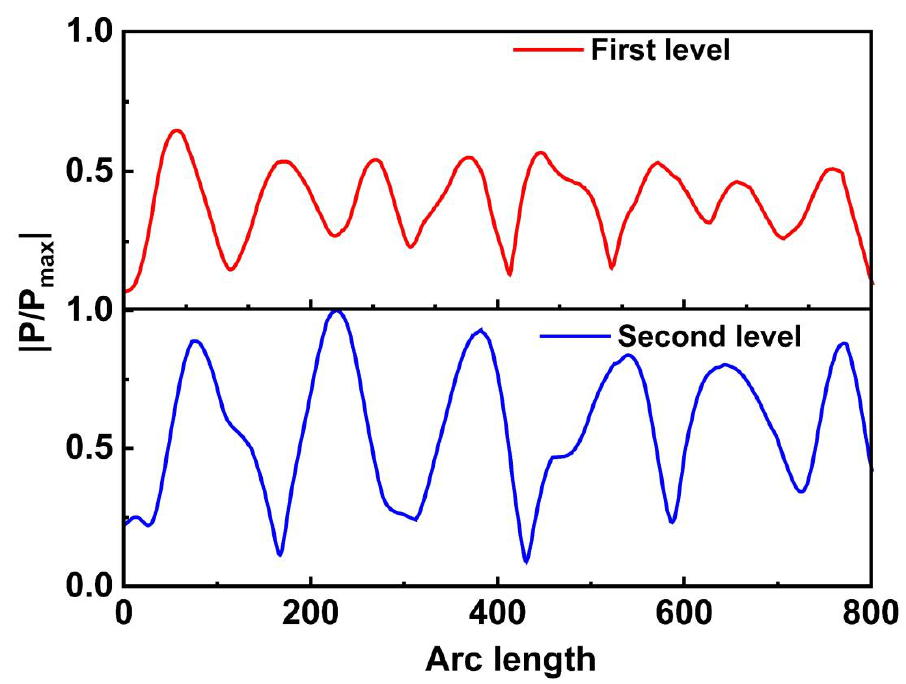
Figure 10. The normalized acoustic pressure generated by the multi-stage SAW device. Based on the results of single-stage separation, the separation of three different particle sizes achieved by multi-stage IDT with an acoustic pressure at 0.45 MPa in the first stage (top) and an acoustic pressure at 0.75 MPa in the second stage (bottom) is shown in Figure 11b, where the red lines represent the largest particles (25 μm), the green for me- dium- sized particles (15 μm), and the blue for the smallest (5 μm) particles. In the first stage, the ARF dominates the larger particles, which causes the particles to flow in the direction of the inclined node. In contrast, the drag force cancels most of the acoustic ra- diation force of the remaining particles, resulting in a small lateral displacement. When these particles enter the second sorting area, the acoustic radiation force continues to sep- arate the largest particles farther away, and when the mixed particles move through the SAW, the medium particles were separated from the mixture by the high-frequency ARF, while the smallest particle still showed little displacement. Therefore, particles with a size of 25 µm can be discriminated in the first stage separation module and particles with a size of 15 µm can besorted in the second stage separation module.